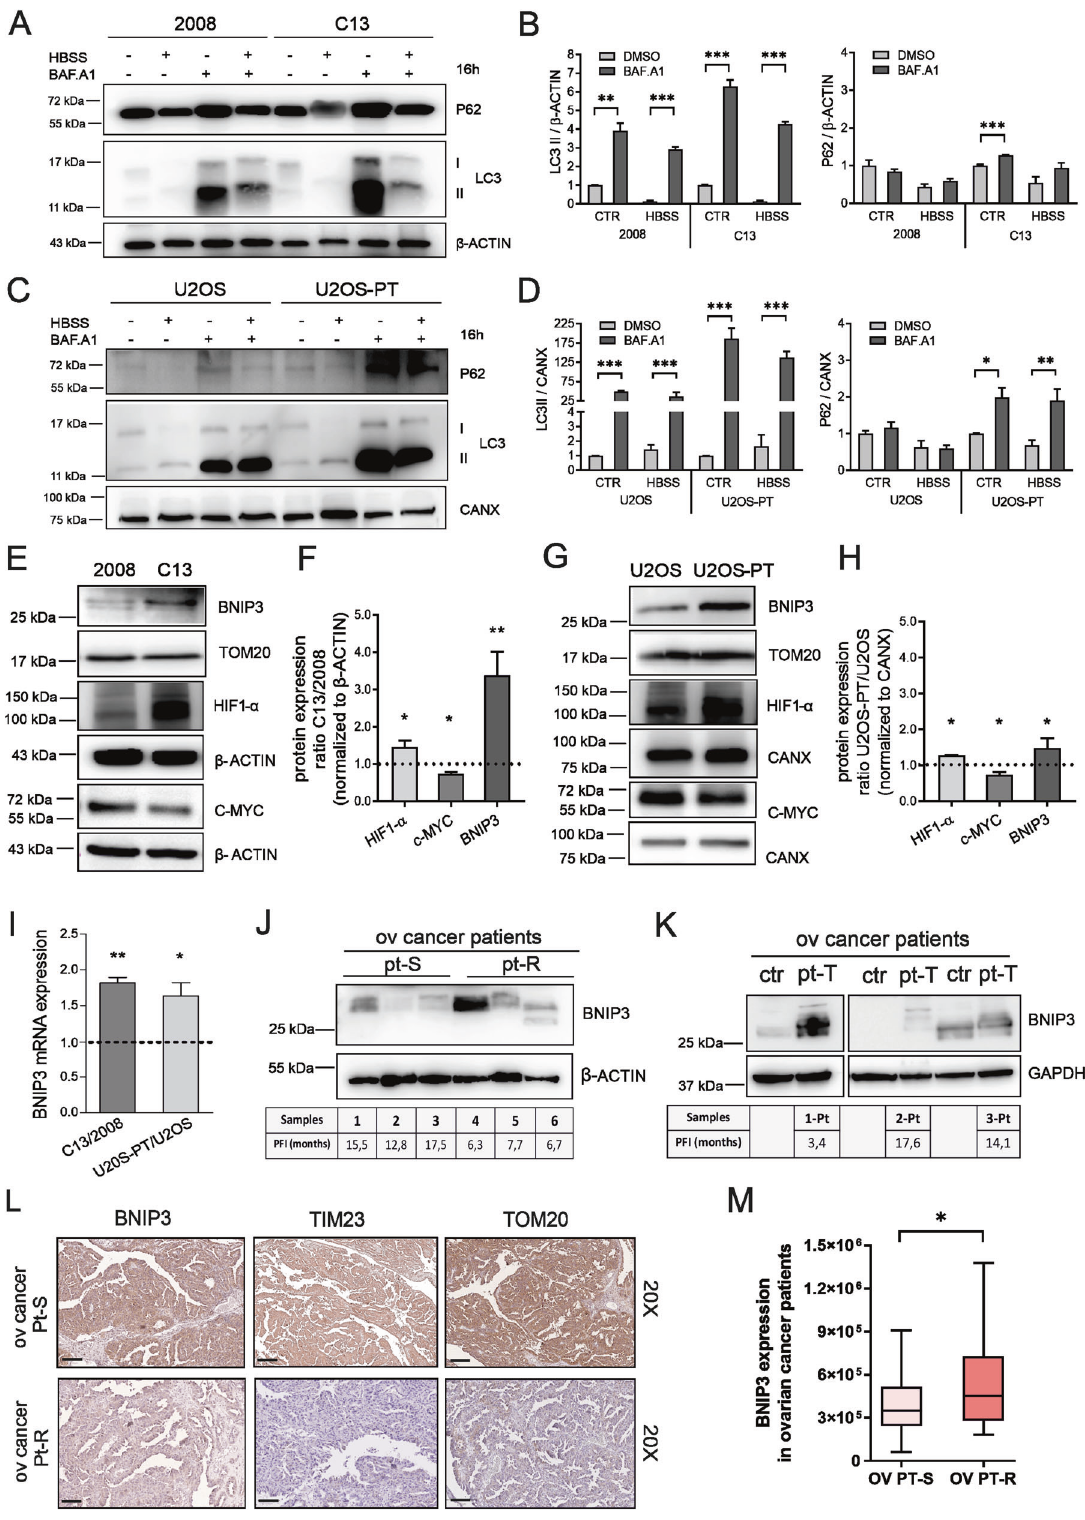
grown in McCoy ’ s 5 A (Lonza) medium, both media were supplemented with 10% fetal bovine serum (FBS), 4 mM glutamine, 100 U/ml penicillin and 100 µg/ml streptomycin, in humidi fi ed condition at 5% CO 2 and 37 °C. For starvation treatment, cells were washed four times and then incubated in